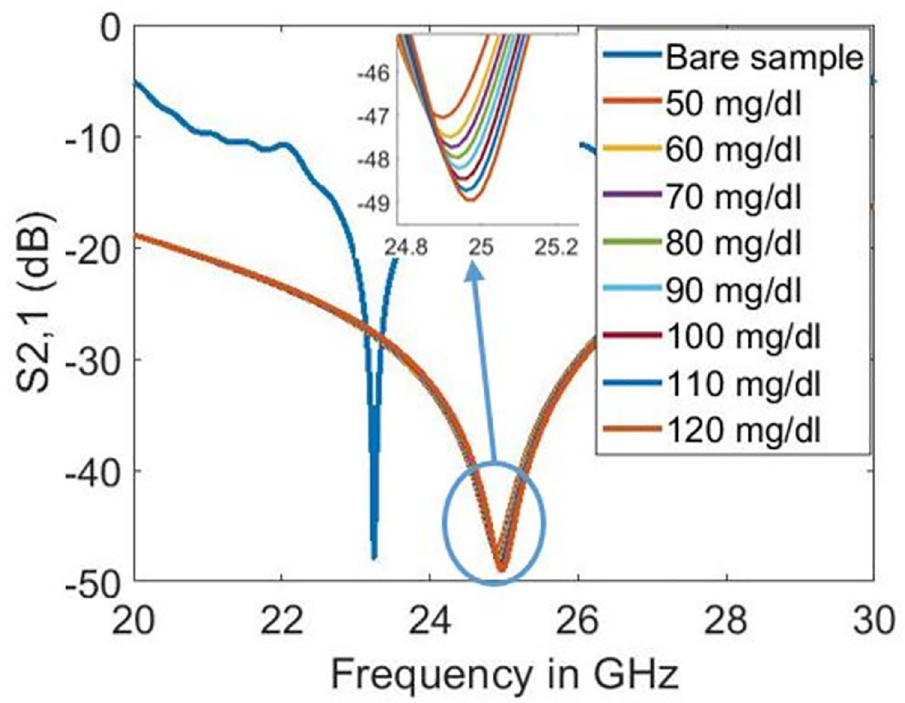
Fig 12. Transmission coefficient responses on different glucose levels with five